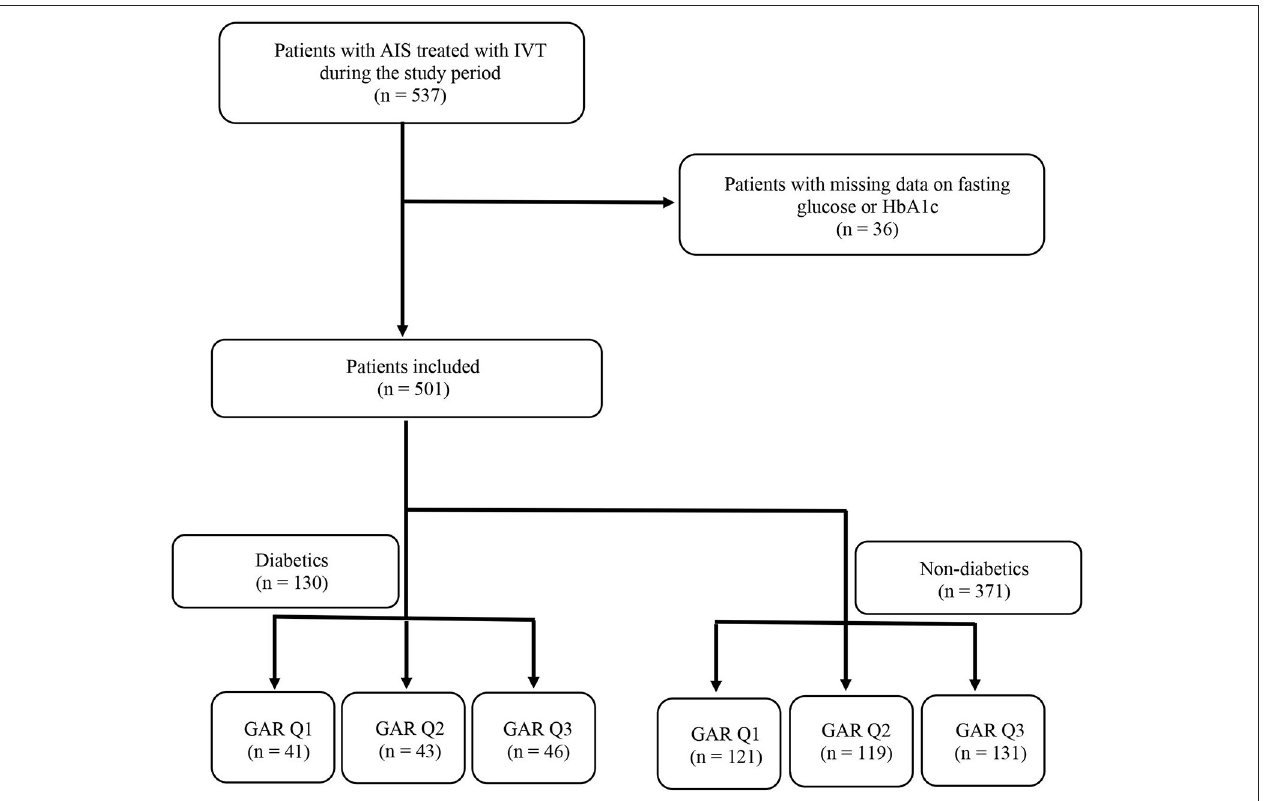
FIGURE 1 | Flow diagram of the study. AIS, acute ischemic stroke; IVT, intravenous thrombolysis; HbA1c, glycated hemoglobin; GAR Q1, first glucose-to-glycated hemoglobin ratio tertile; GAR Q2, second glucose-to-glycated hemoglobin ratio tertile; GAR Q3, third glucose-to-glycated hemoglobin ratio tertile.